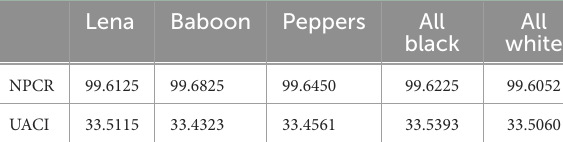
TABLE 13 NPCR and UACI in the proposed image encryption algorithm. Lena Baboon Peppers All